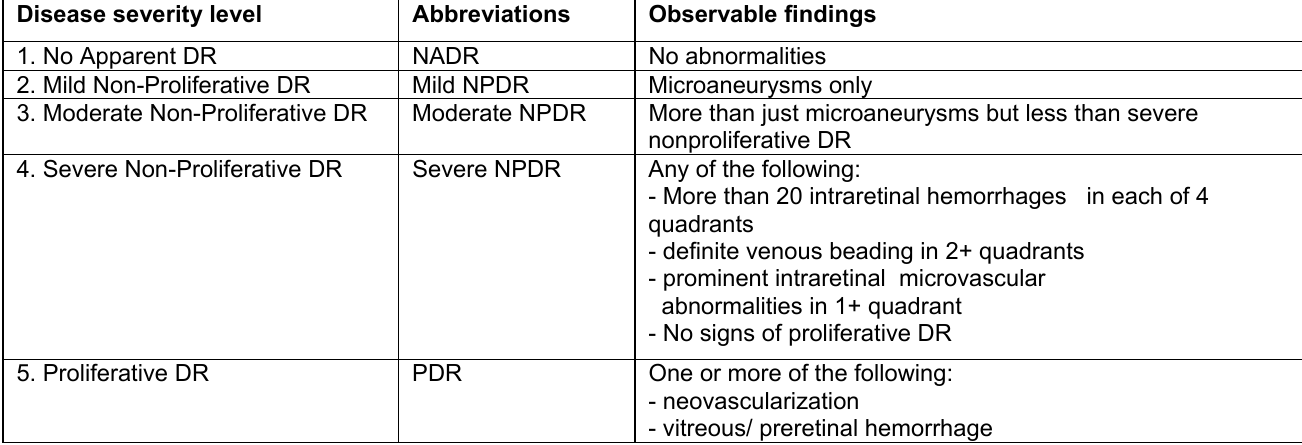
Table 1. The classification and observable findings of DR according to the Diabetic Retinopathy Severity